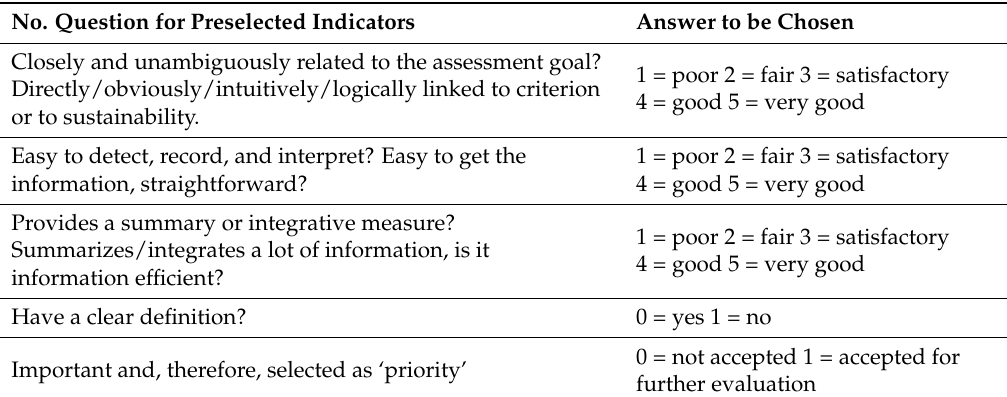
Table A7. A sampled questionnaire for selecting